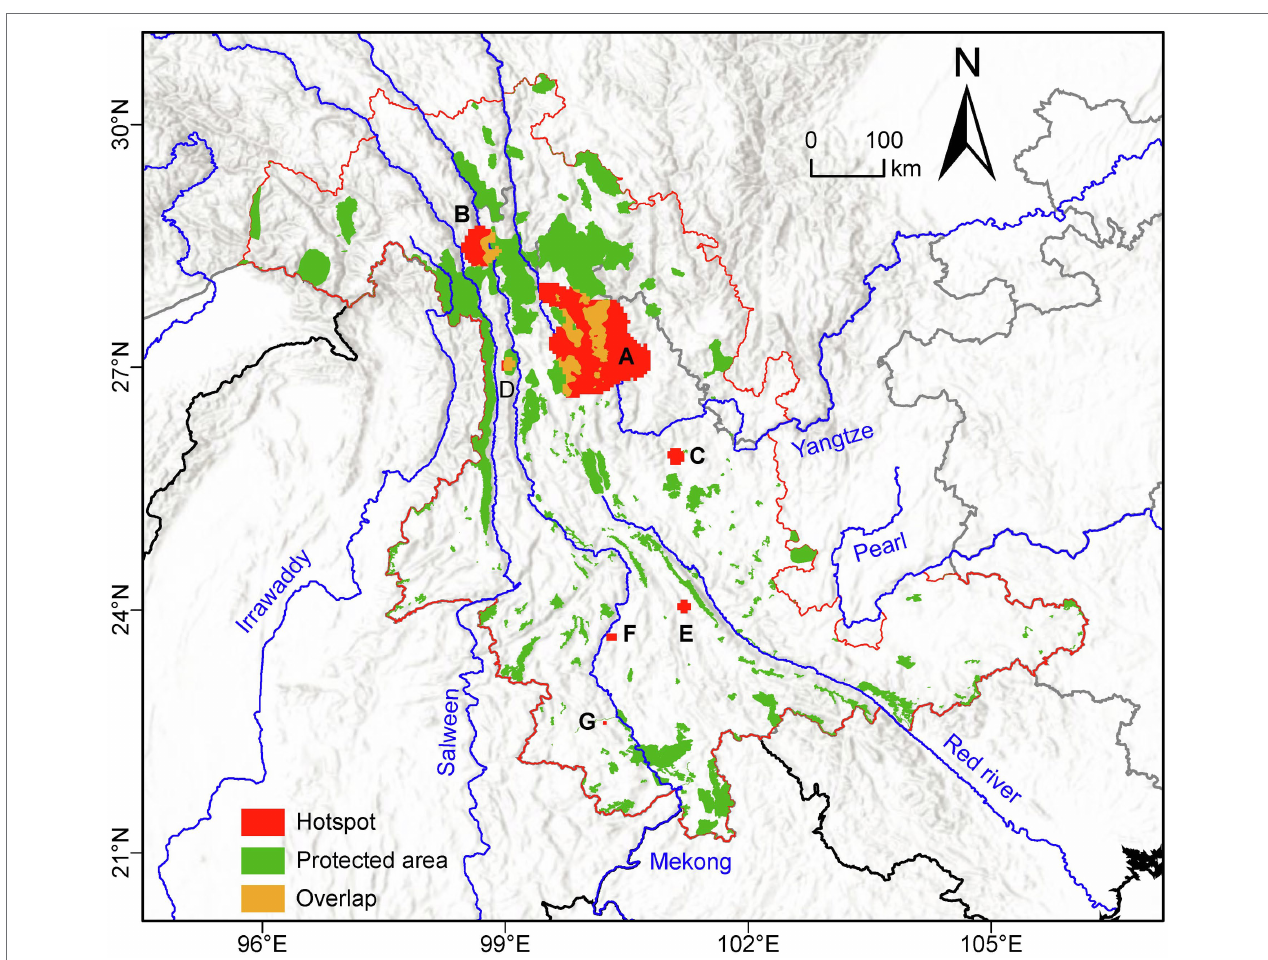
FIGURE 4 | Location of the protected areas (green) and the seven genetic diversity “hotspots” (A-G; red) identified in the current study in the Longitudinal Range Gorge Region (LRGR). Areas of overlap between protected areas and “hotspots” are shown in